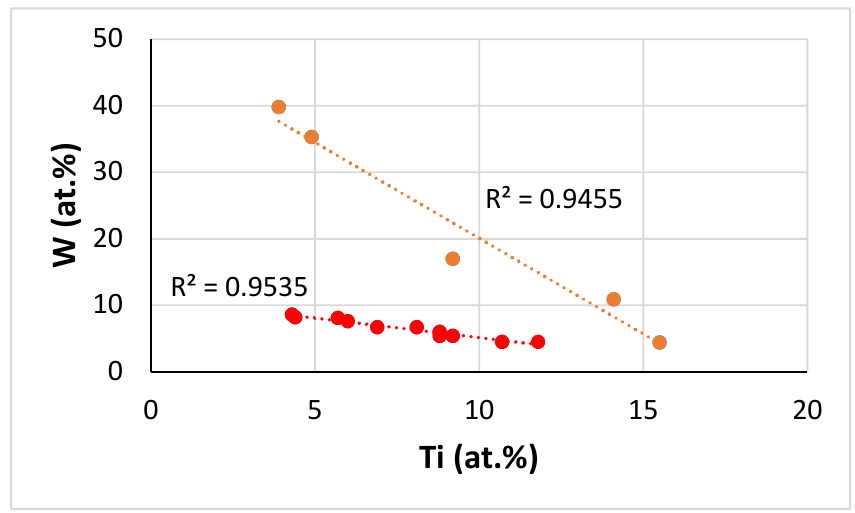
Figure 12. Tungsten versus Ti concentration in Nb ss in the alloys JZ2, JZ3 and JZ3+ (orange data) and Nb-silicide-based alloys with Hf, Mo, Si, Ti and W additions [28,40].